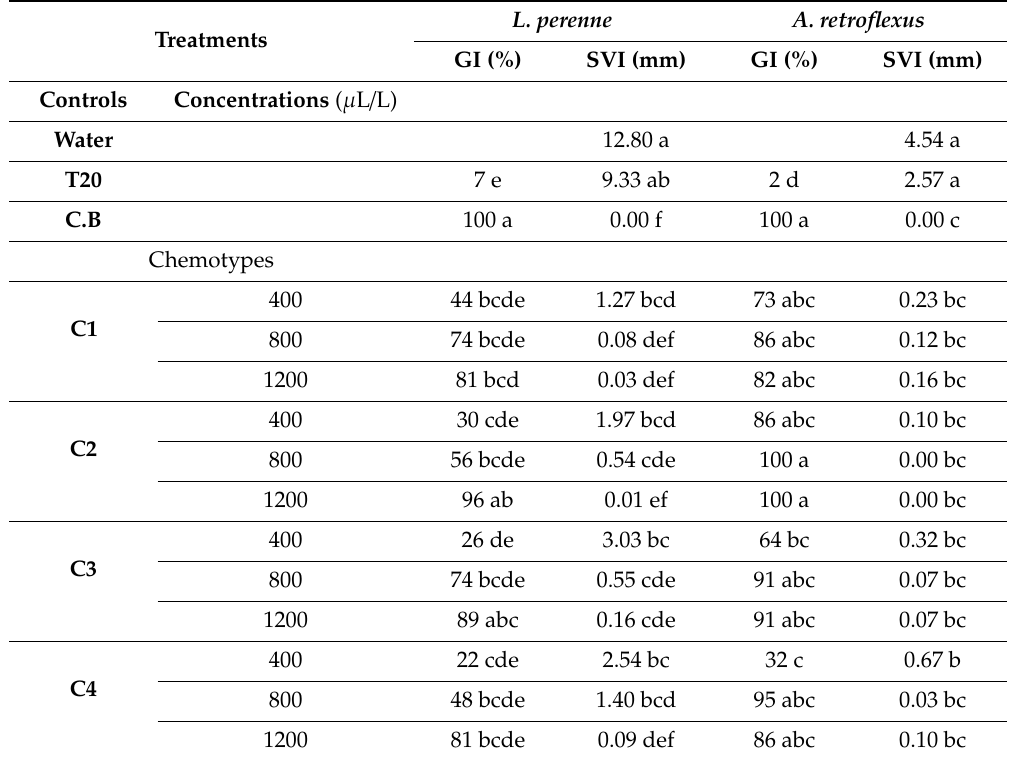
Table 4. E ff ect of the di ff erent EOs on seed germination inhibition and on seedling vigor index of A. retroflexus and L. perenne .